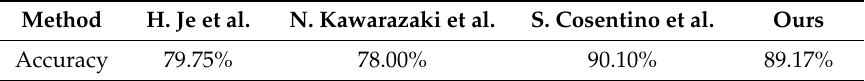
Table 9. Accuracy comparison of related work with our